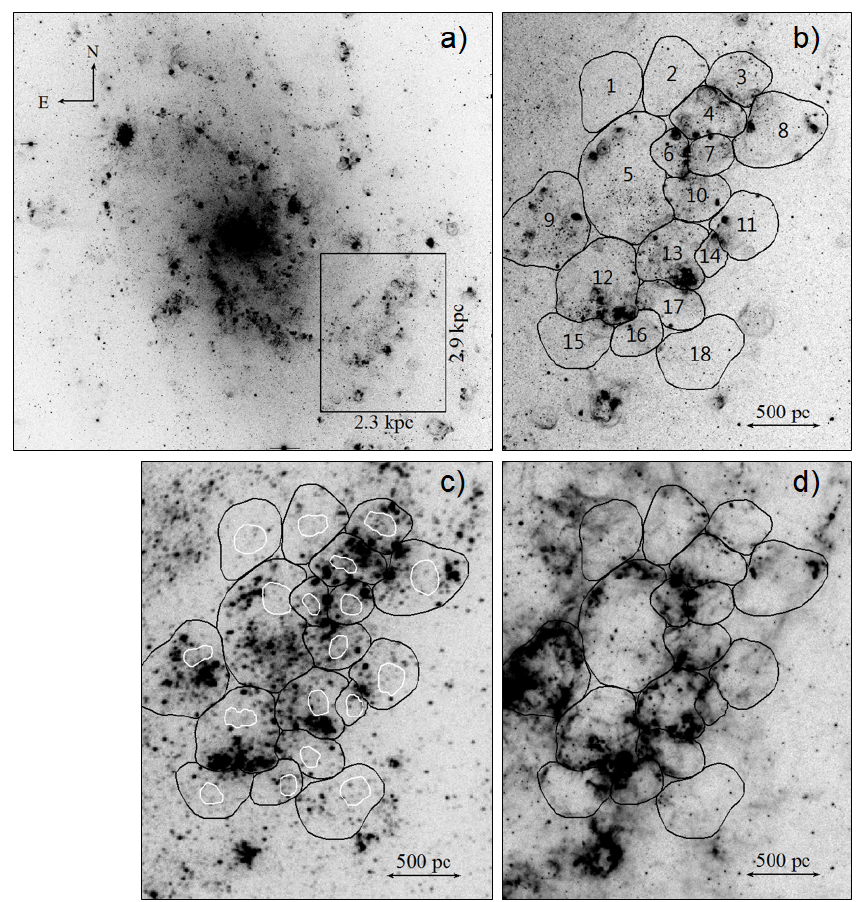
Fig. 1. Panels: a) H α -band image of the M 33 galaxy, the boxed area marks the field analyzed in this study; b) an enlarged image of the boxed area, the black contours mark the boundaries of identified supershells and numbers indicate their IDs; c) FUV emission map (GALEX), the white contours mark the boundaries of the oldest stellar population areas; d) dust emission (Spitzer/IRAC, 8 µ m). North is up, East is to the